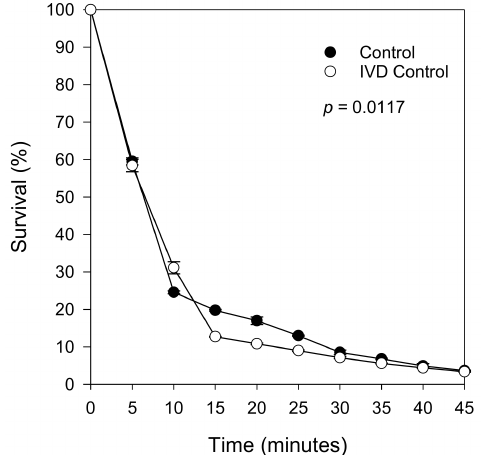
Figure 4. Survival curves during H 2 O 2 stress of S. cerevisiae SKQ2n cultured in YNB with 2% glucose without berry extracts (control) and after in vitro digestion without berry extracts (IVD blank; only in vitro digestion background chemicals, without berry extracts). Significant differences between treatments were detected using Tukey’s Studentized Range (HSD) test at the 5% level of significance. Data points are averages of replicated samples from three separate (independent) stress assays ( ±